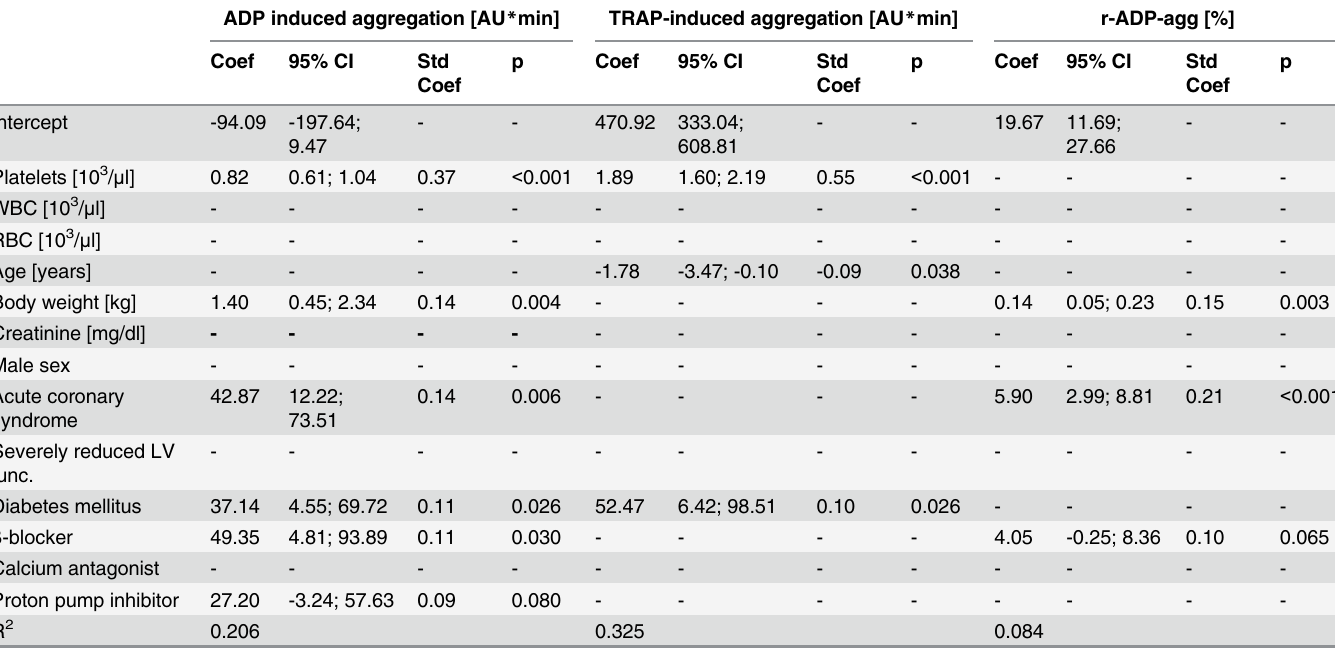
Table 3. Factors significantly associated with aggregation markers in multiple regression analyses (all N = 351).